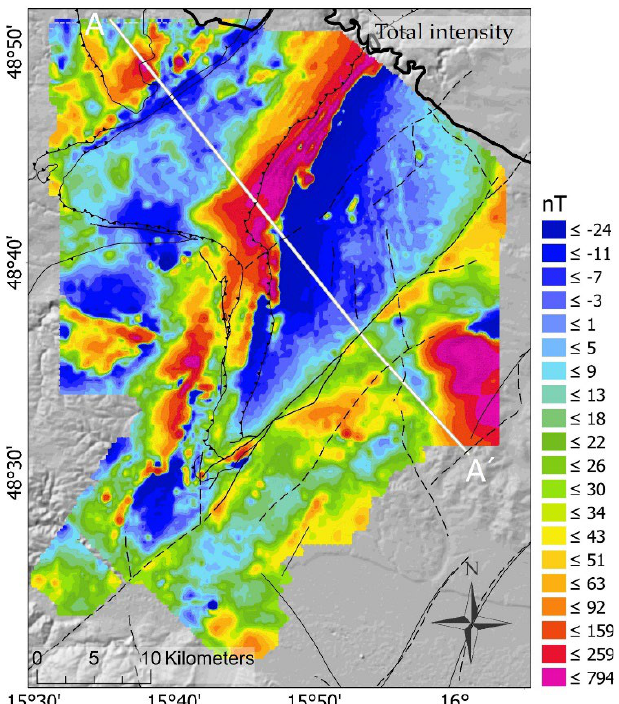
Figure 2. Reprocessed magnetic total intensity in Nanotesla (nT) covered by the vintage airborne data (red boxes in Figure 1a); the white line shows the location of profile A where different geophysical datasets are compared, legend for tectonic structures: see Figure 1b. Background map: Lidar image with a 10 × 10 m resolution.